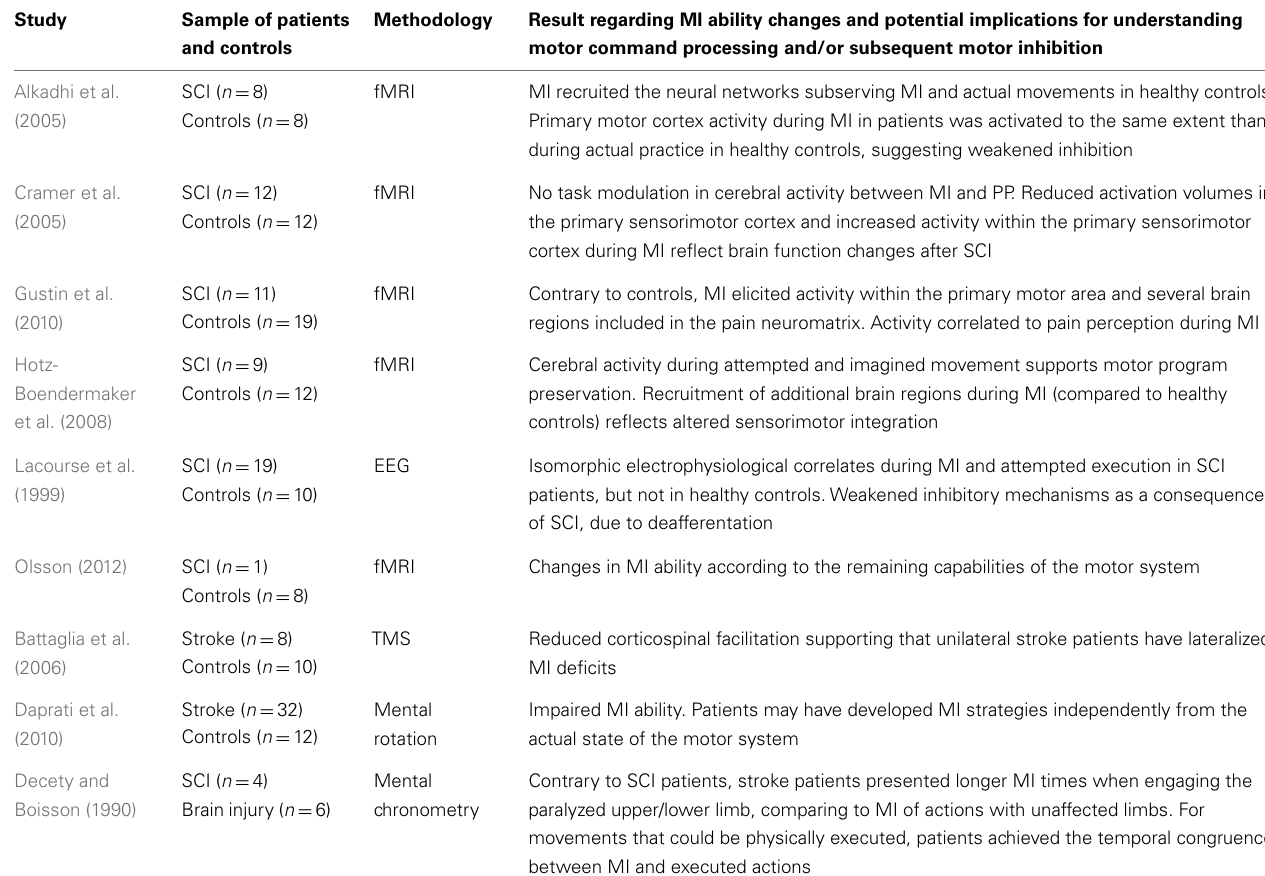
Table 2 | Studies looking at the motor command during motor